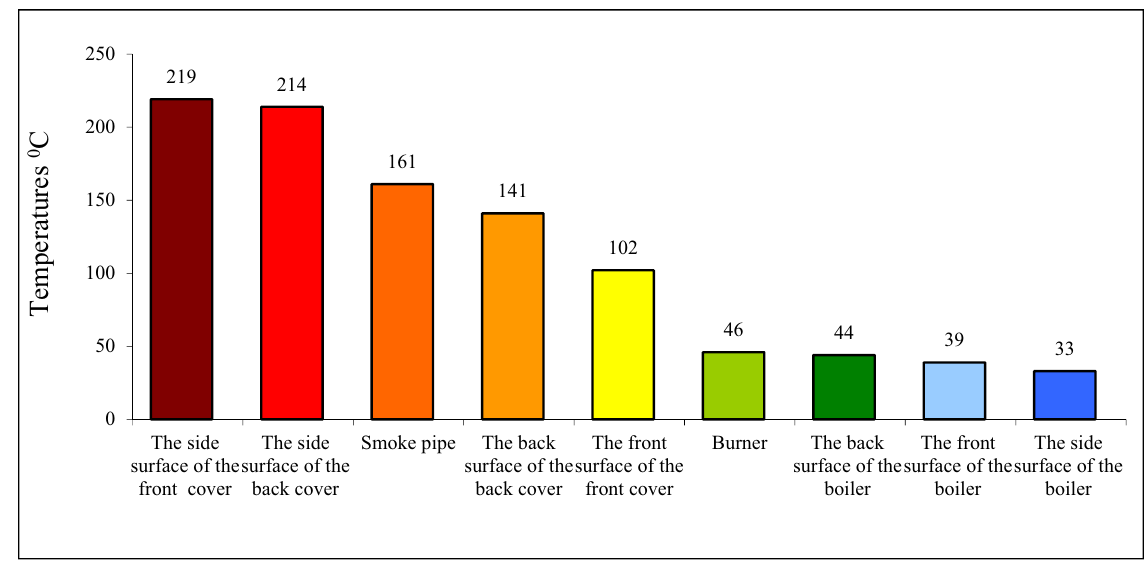
Figure 3: Pareto diagram of surface temperature before improvement